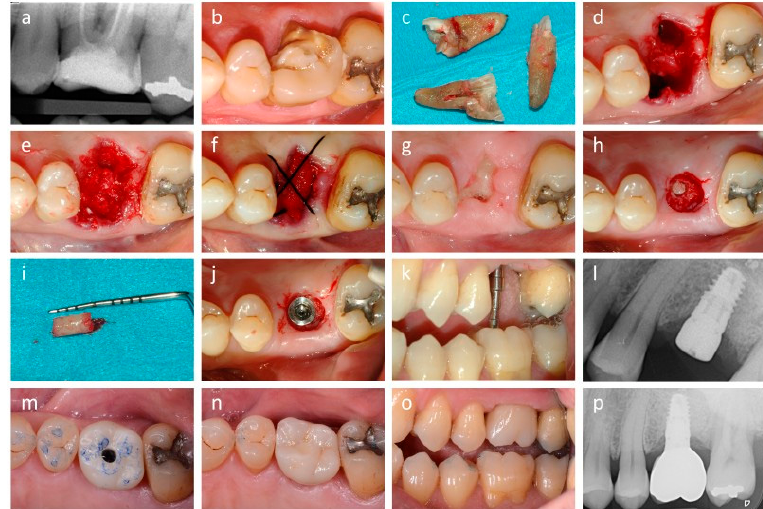
Figure 2. An illustrative case of a patient (patient #1) treated with enzyme-deantigenic equine bone particulate combined with a hydrogel carrier (EDEBEX). ( a ) Intra-oral X-ray at presentation; ( b ) clinical appearance at presentation; ( c ) the tooth after been cut to be extracted atraumatically; ( d ) the post-extractive socket; ( e ) the socket grafted with EDEBEX; ( f ) the gingival rims are stabilized with a cross stitch; ( g ) soft tissue healing at implant insertion; ( h ) and ( i ) a bone biopsy is collected and ( j ) and ( k ) an implant placed. ( l ) intra-oral X-ray following implant placement; ( m ), ( n ), ( o ) the final prosthesis delivery; ( p ) intra-oral X-ray recorded at the last control visit (21.6 months after implant placement). A representative image of a histologic slide is shown in Figure 3.